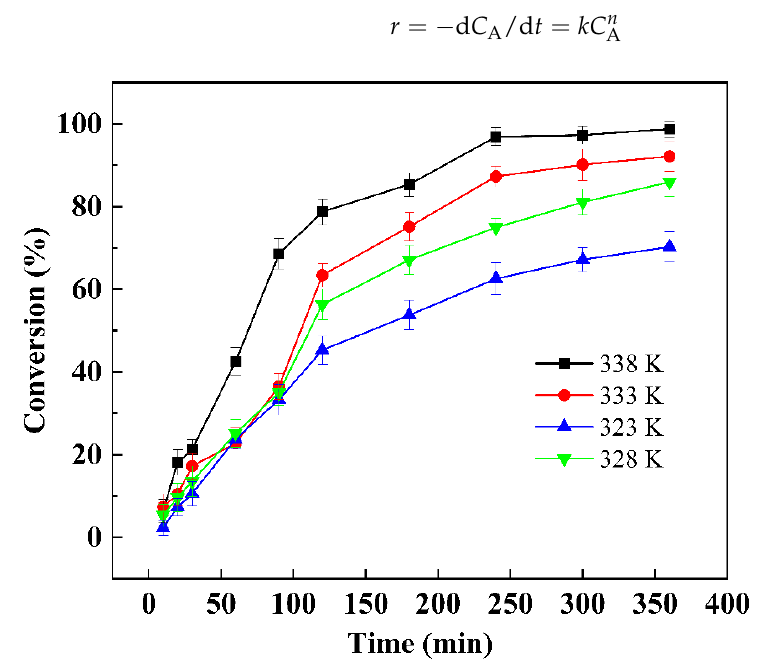
Figure 5. Jatropha oil conversion variation of CaNa/AC at different temperatures.